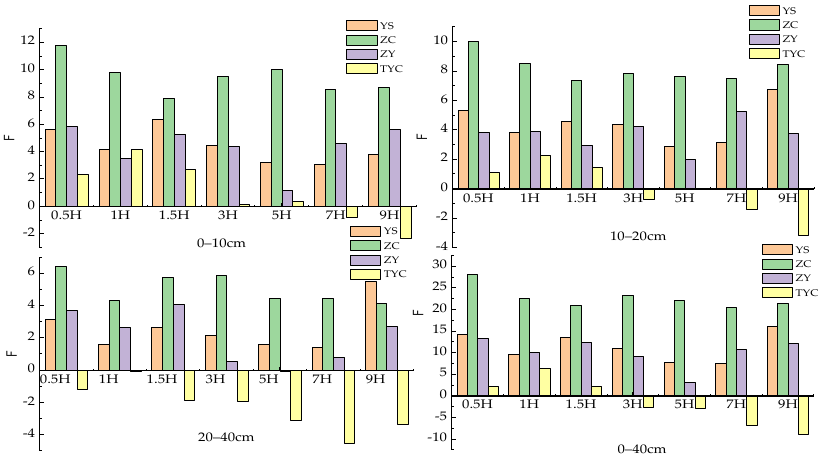
Figure 10. Comprehensive evaluation index of soil aggregates stability at different distances from shelterbelts.